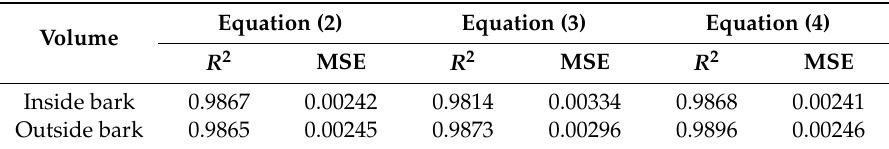
Table 2. Fit statistics for Equations (2)–(4) for plantation grown red pine in Ontario. ( R 2 = coe ffi cient of determination, MSE = mean square